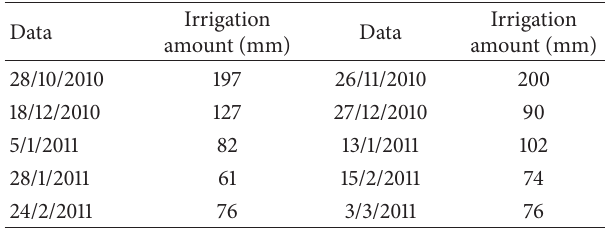
Table 2: Irrigation times and amount of water used in each irri-